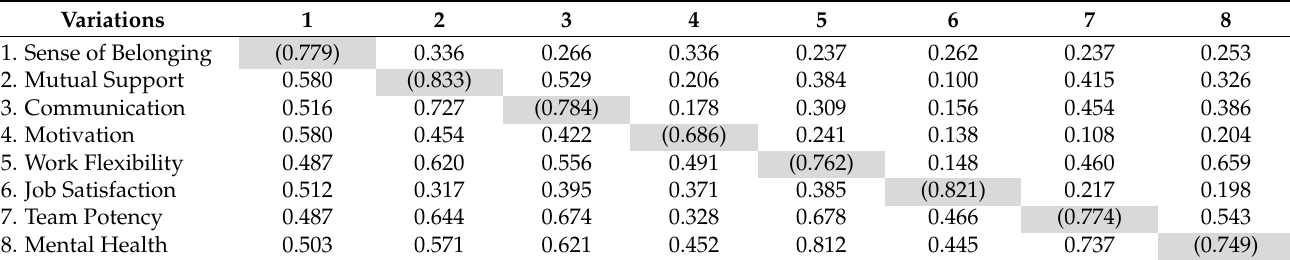
Table 4. Verification